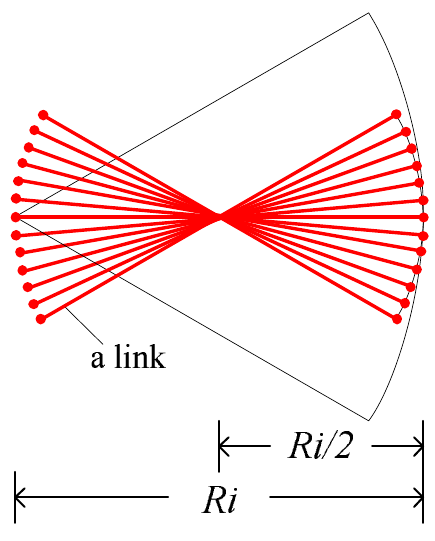
Figure 7. The proof of Theorem